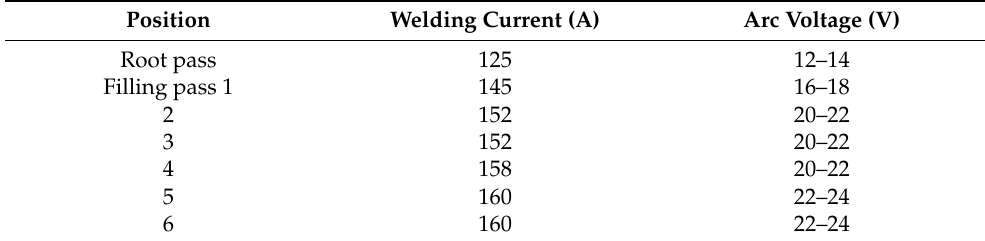
Figure 2. Conventional V-groove geometry. Table 2. Welding process parameters.